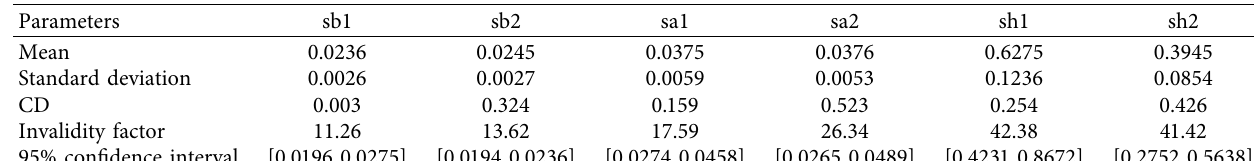
Table 4: Parameter estimation of NFMM.